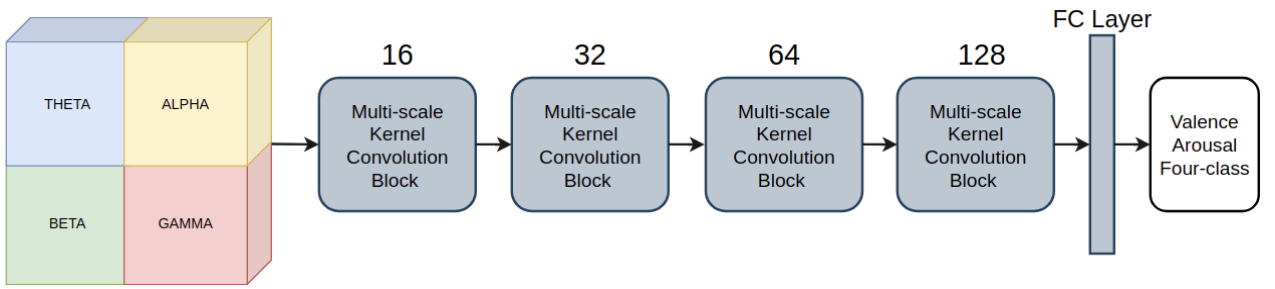
Figure 3. The proposed method.